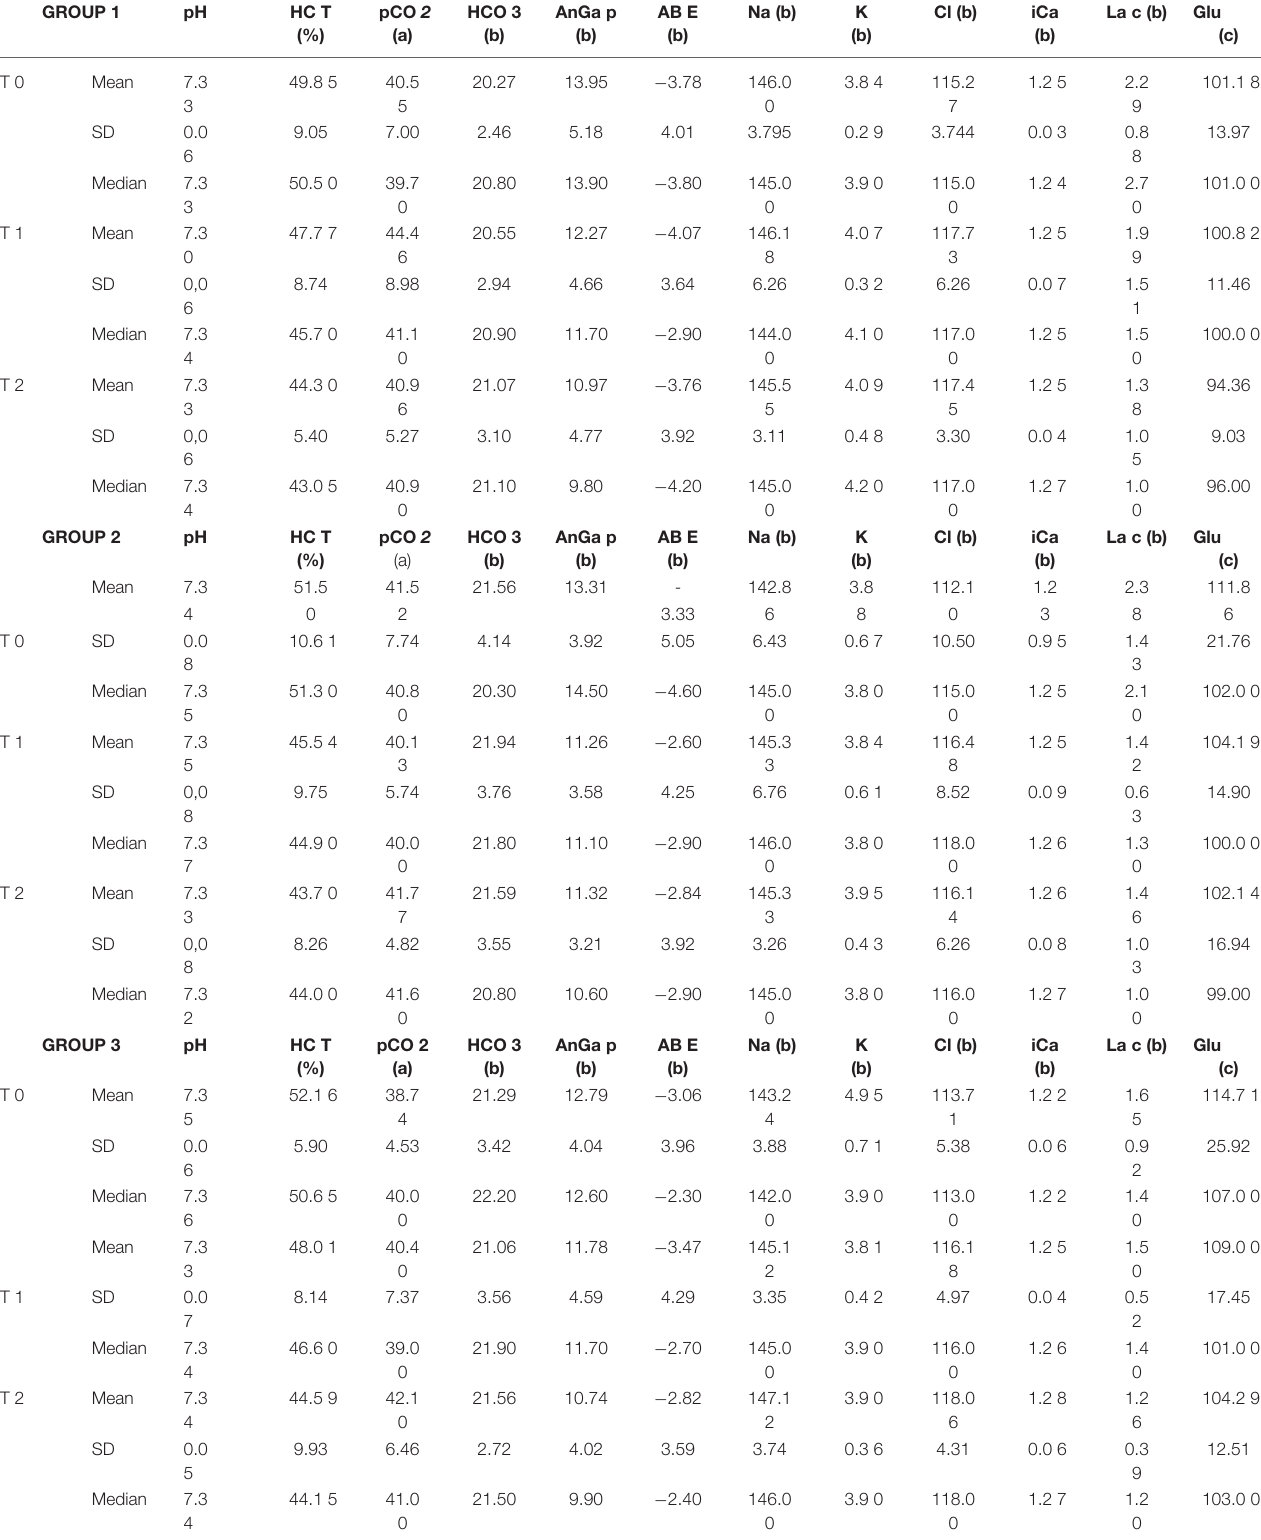
TABLE 2 | Average, SD and median values of the various parameters analyzed at T0, T1 and T2 in Groups 1, 2 and 3 dogs. GROUP